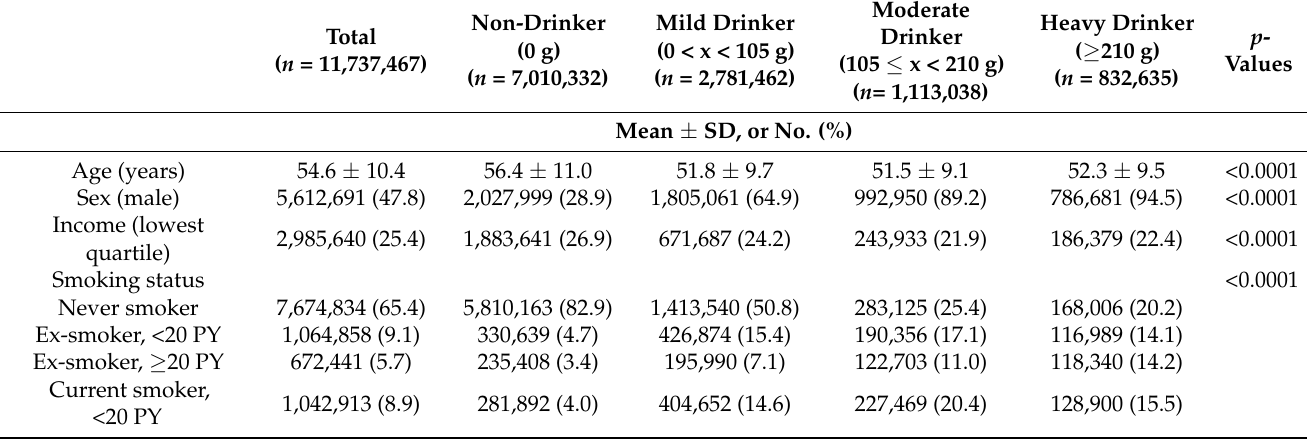
Table 1. Baseline characteristics according to average weekly alcohol